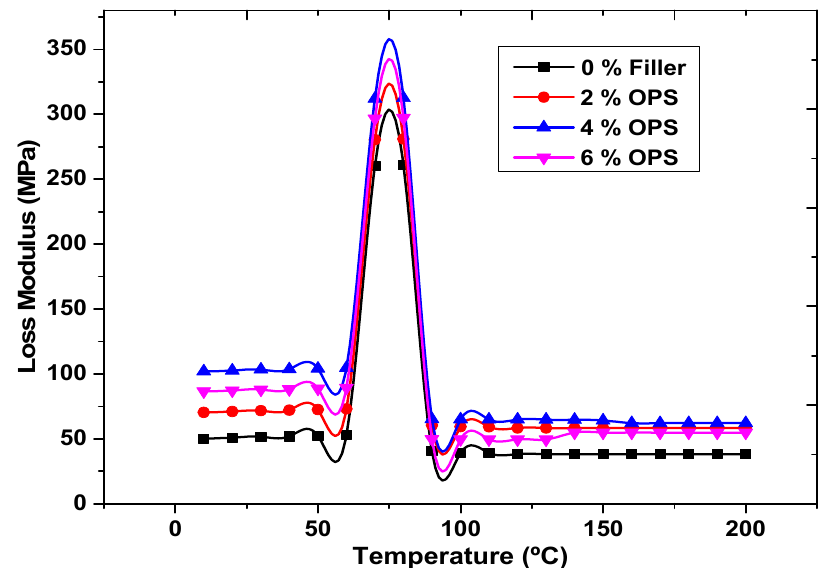
Figure 9. Effectiveness of the OPS nanofiller content on the flax/epoxy-based hybrid composites on the loss